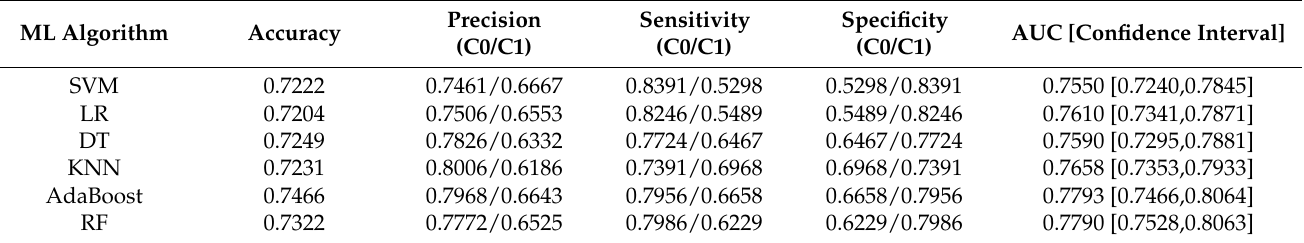
Table 5. Predictive performance of ML models (10 FCV) with respect to various validation